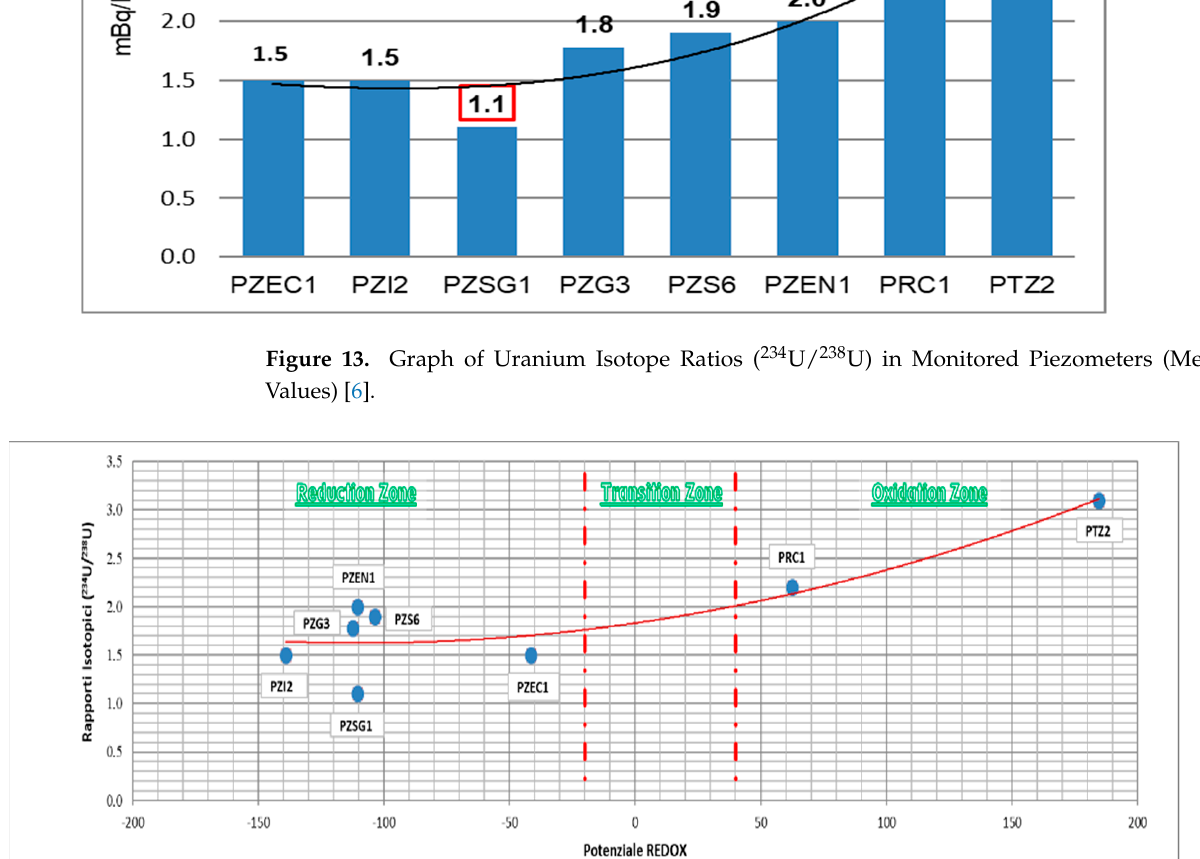
Figure 14. Graph of Uranium–Potential Redox Isotope Ratios in Monitored Piezometers (Median Values) [6].